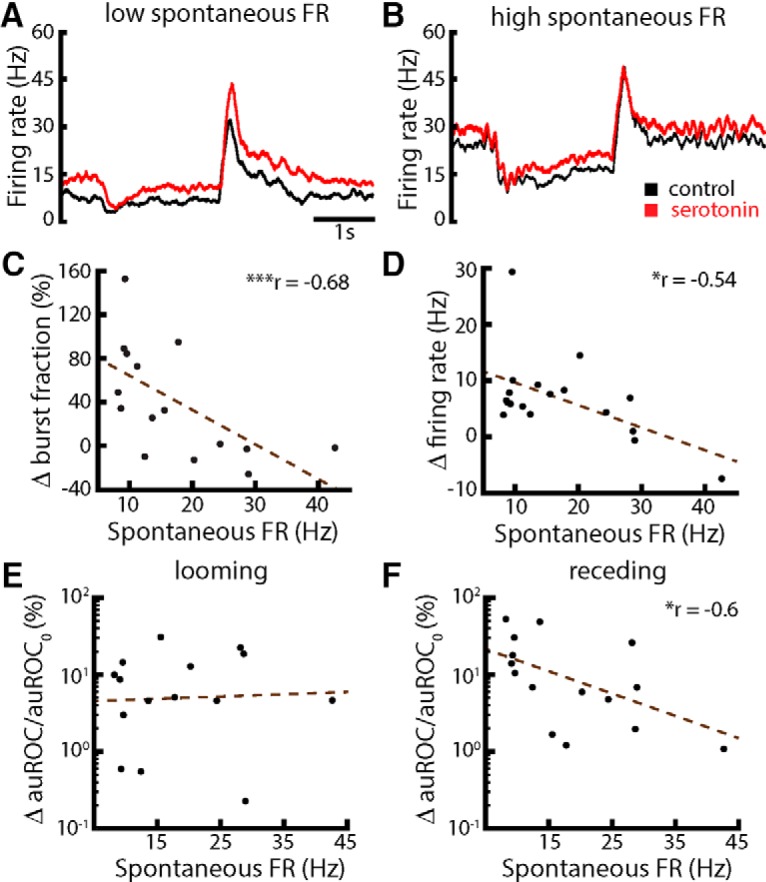
The magnitude of the effect of serotonin on ELL pyramidal cell’s responses to moving objects was negatively correlated with spontaneous firing rate. A, PSTH of a representative cell with low (9.1 Hz) spontaneous firing rate during control (black) and after serotonin application (red). B, Same as A but for a representative cell with high (28.9 Hz) spontaneous firing rate. For both panels, the time scale is the same and the object’s speed during looming and receding motion was 8 cm/s. C, Percentage change in burst fraction [i.e., 100*(BFserotonin – BFcontrol)/BFcontrol] between control and serotonin conditions (measured during baseline period) as a function of spontaneous firing rate measured before serotonin application. Both quantities were significantly correlated (r = −0.68, p = 0.003, n = 15). D, Relative change in firing rate [i.e., 100*(FRserotonin – FRcontrol)/FRcontrol] as a function of the spontaneous firing rate. Both quantities were significantly correlated (r = −0.54, p = 0.02, n = 15). E, Percentage change in auROC [i.e., 100*(auROCserotonin − auROCcontrol)/auROCcontrol] as a function of spontaneous firing rate for looming motion. No significant correlation was observed (r = −0.06, p = 0.84, n = 15). F, Same as E but for receding motion. Both quantities were significantly correlated (r = −0.6, p = 0.03, n = 15).